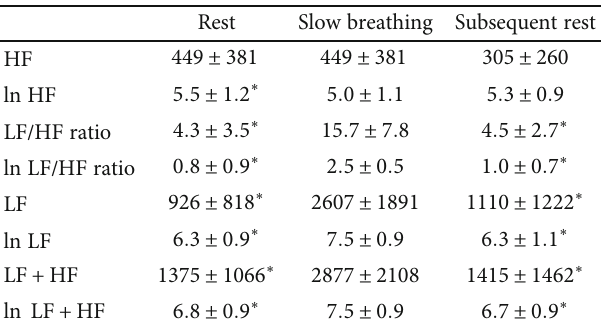
Table 1: Resting, slow breathing, and subsequent resting values in the supine